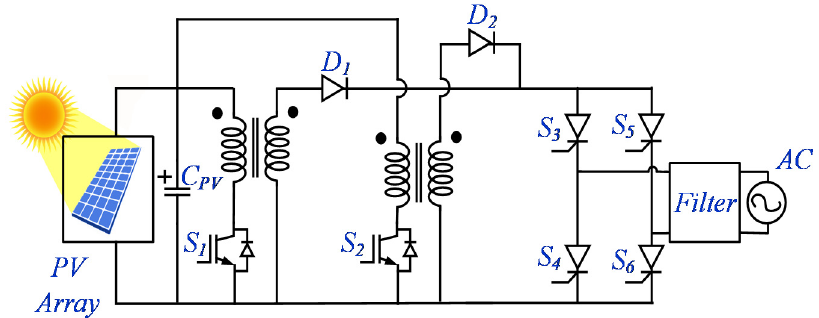
Figure 26 . CCM control interleaved fly-back converter . Figure 26. CCM control interleaved fly-back converter.